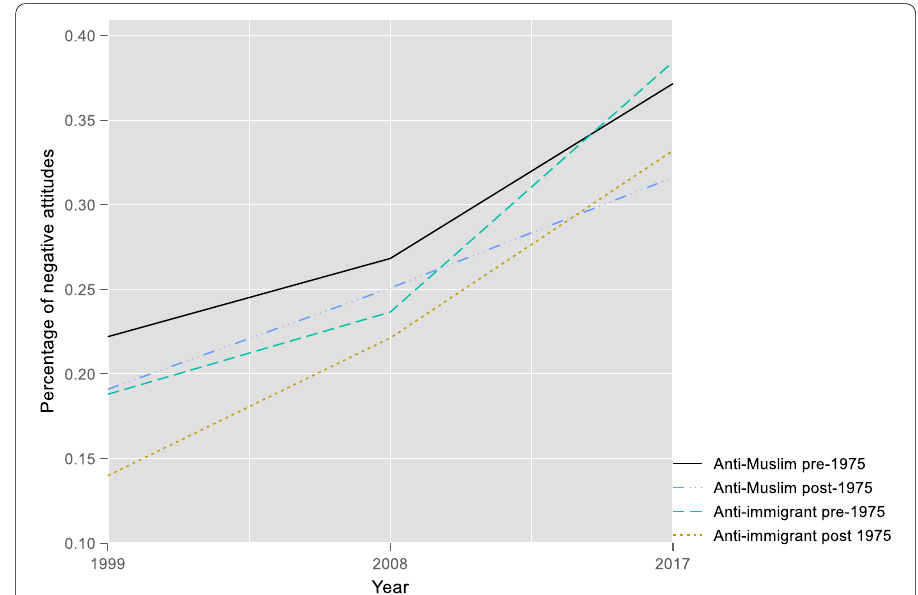
Fig. 5 Anti-Muslim and anti-immigrant attitudes by age group Eastern Europe (As individuals born after 1975 were not old enough to participate in the 1990 survey, these figures are based on data from 1999 to